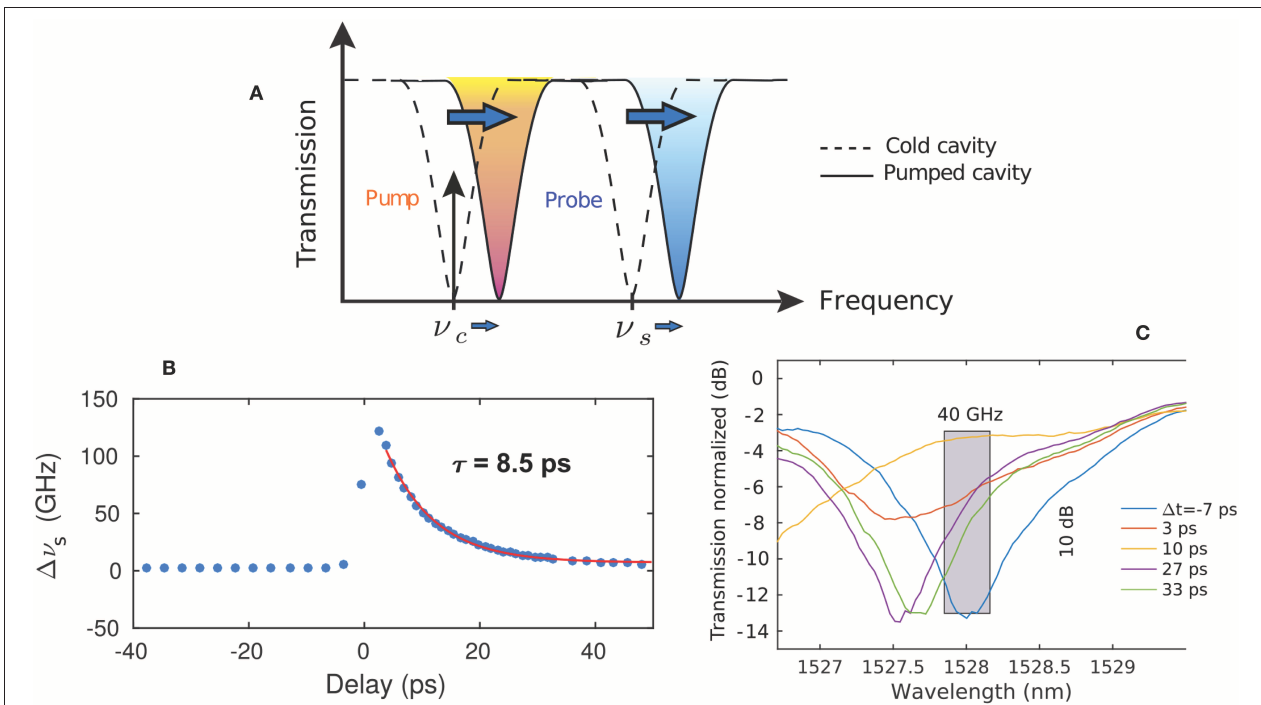
FIGURE 4 | Characterization of the non-linear dynamics of the AOG. (A) Principle of the pump-probe measurement. One resonance of the nanocavity under test is optically pumped, which induces a blue-shift of all the resonances. (B) Evolution of the instantaneous resonance frequency of a probed resonance as a function of the delay between pump and probe pulses, with an injected pump energy about 1 pJ. An exponential time decay of 8.5 ps is obtained. (C) Evolution of a probed resonance spectrum as a function of time, to estimate the switching contrast: the transmission is increased by 10 dB when the AOG is pumped, over a bandwidth of 40 GHz. The pump energy is set at 3.6 pJ.